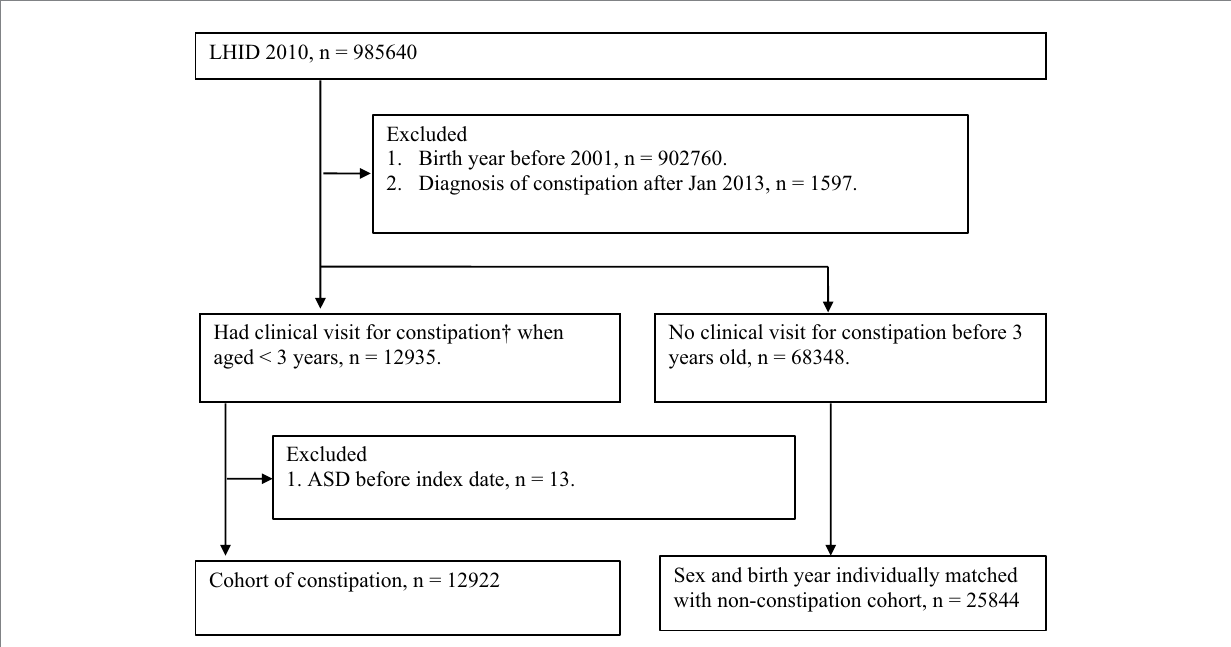
FIGURE 1 study flow chart. † Patients had constipation (ICD-9564.0, two or more OPD visits or at least one inpatient discharge note) when aged <3 years from 2001 to